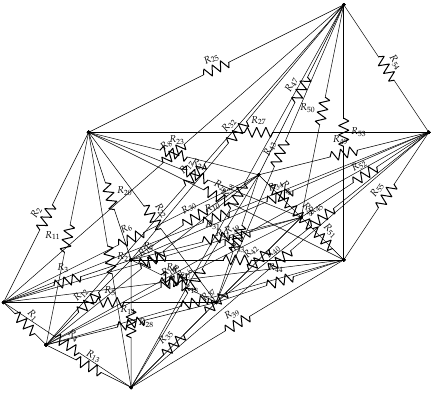
Figure 9. A multi-connected resistive grid from Figure 8b.